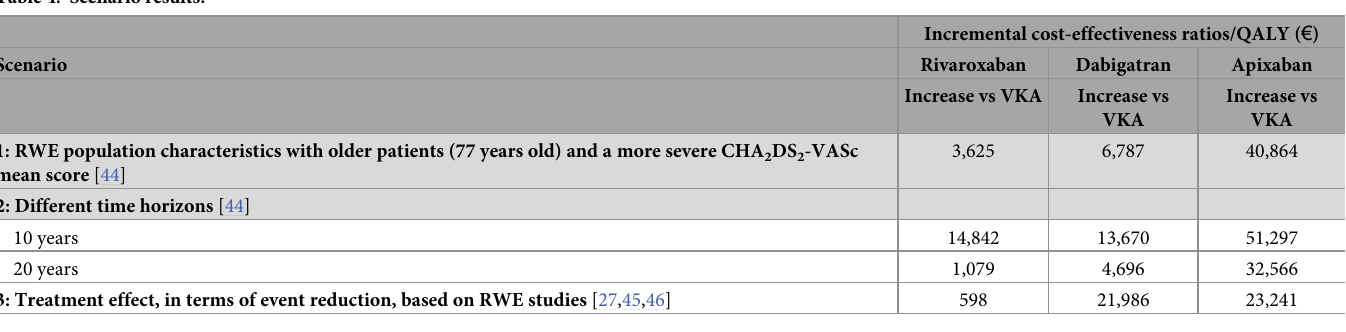
Table 4. Scenario